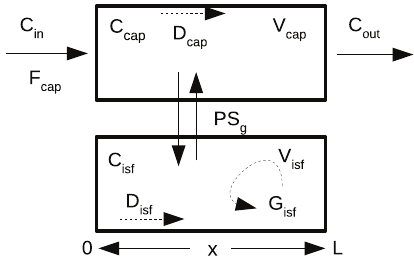
Figure 1. Capillary-tissue exchange unit. Fluid flows with velocity F *L/V along the capillary from the entrance at x = 0 to the exit cap cap at x = L, and exchanges across the capillary wall into a stagnant extravascular region with conductance PS, the permeability-surface area product. The input is a bolus of solute, C